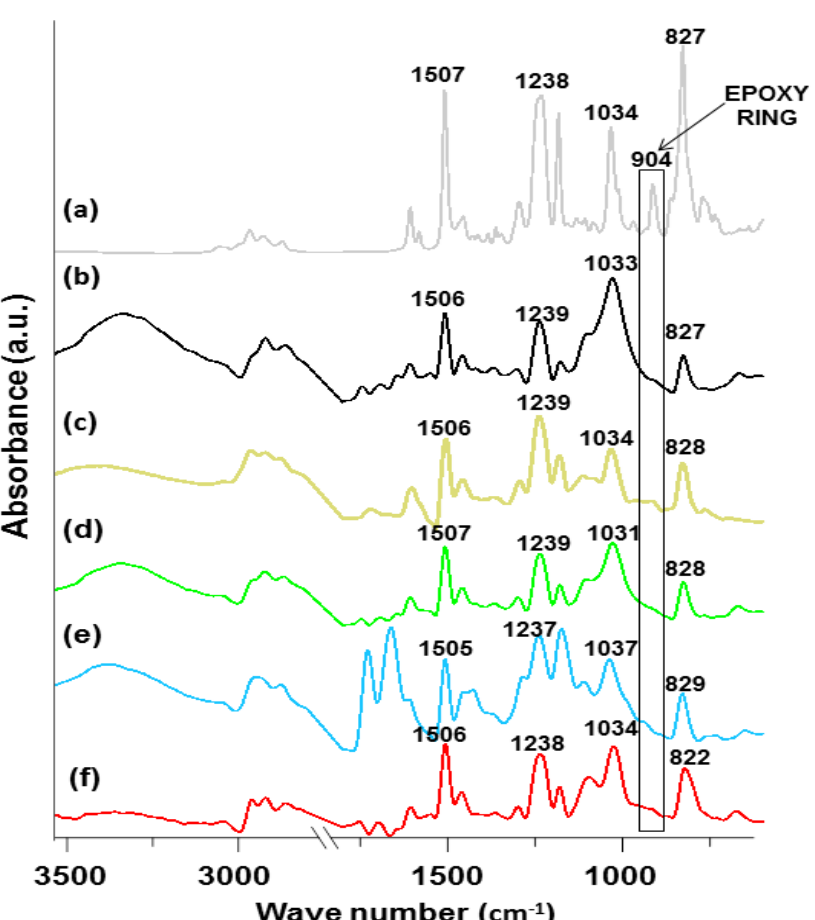
Figure 4. ATR/FT-IR spectra of the obtained materials: ( a ) Non-crosslinked epoxy resin; ( b ) sample without eco-filler; ( c ) sample with 30 wt.% of eco-filler; ( d ) sample with 20 wt.% of eco-filler; ( e ) sample with 10 wt.% of eco-filler and ( f ) sample with 5 wt.% of eco-filler. Table 2. Sample wavelength values with the attributed intramolecular vibrations. Fibers Content (wt.%)